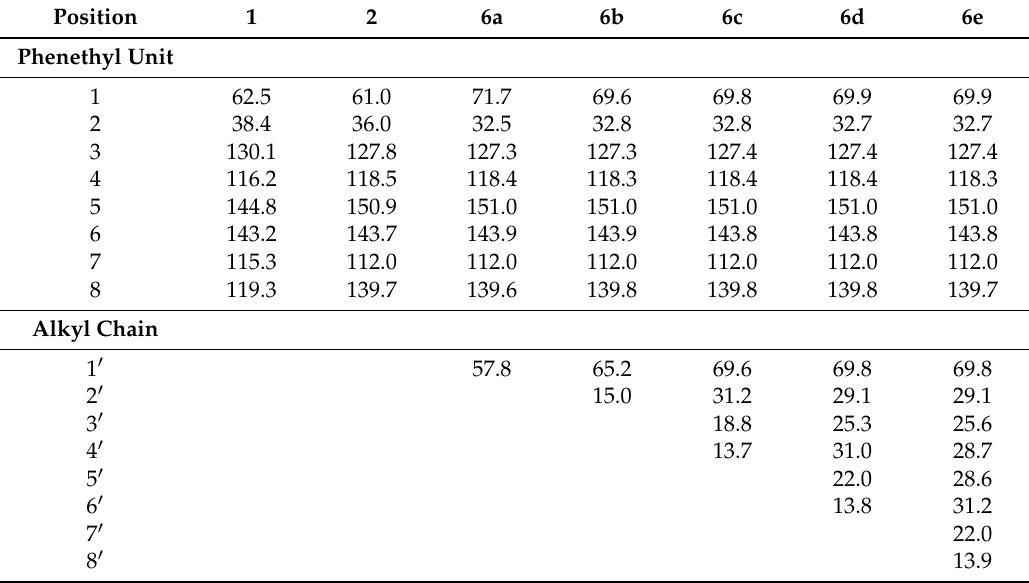
Table 2. 13 C-NMR Chemical Shifts (ppm) (125.76 MHz, DMSO- d 6 , 303 K) for compounds 1 , 2 and 6a – e . Position